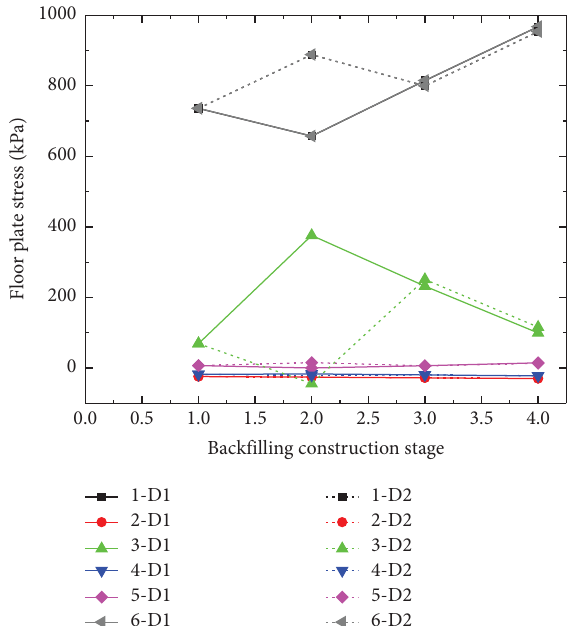
Figure 22: Stress of the foor in the middle-to-side backflling mode.